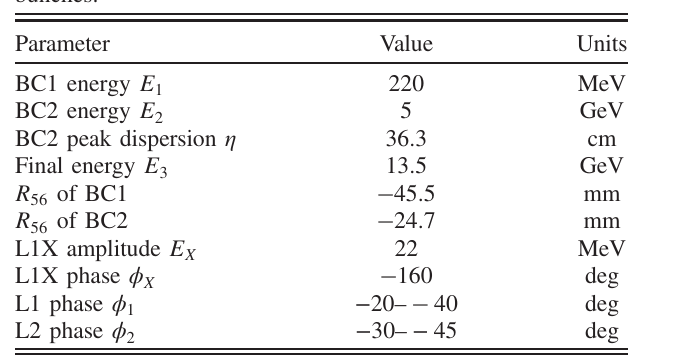
FIG. 7. The transverse distribution of the two bunches with intensity profile in the middle of